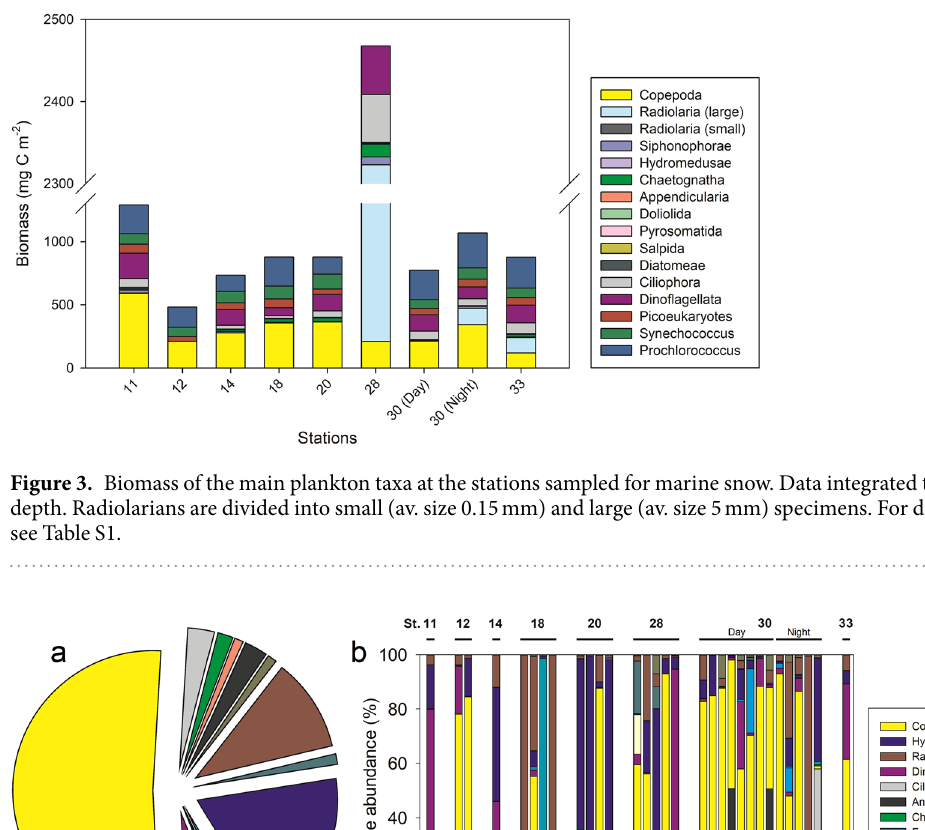
variable with Trichodesmium , Synechococcus , and Prochlorococcus accounting for 13 ± 26%, 1.8 ± 8.4%, and 2.0 ± 6.8% of the reads per particle (average ± standard deviation, n = 31).